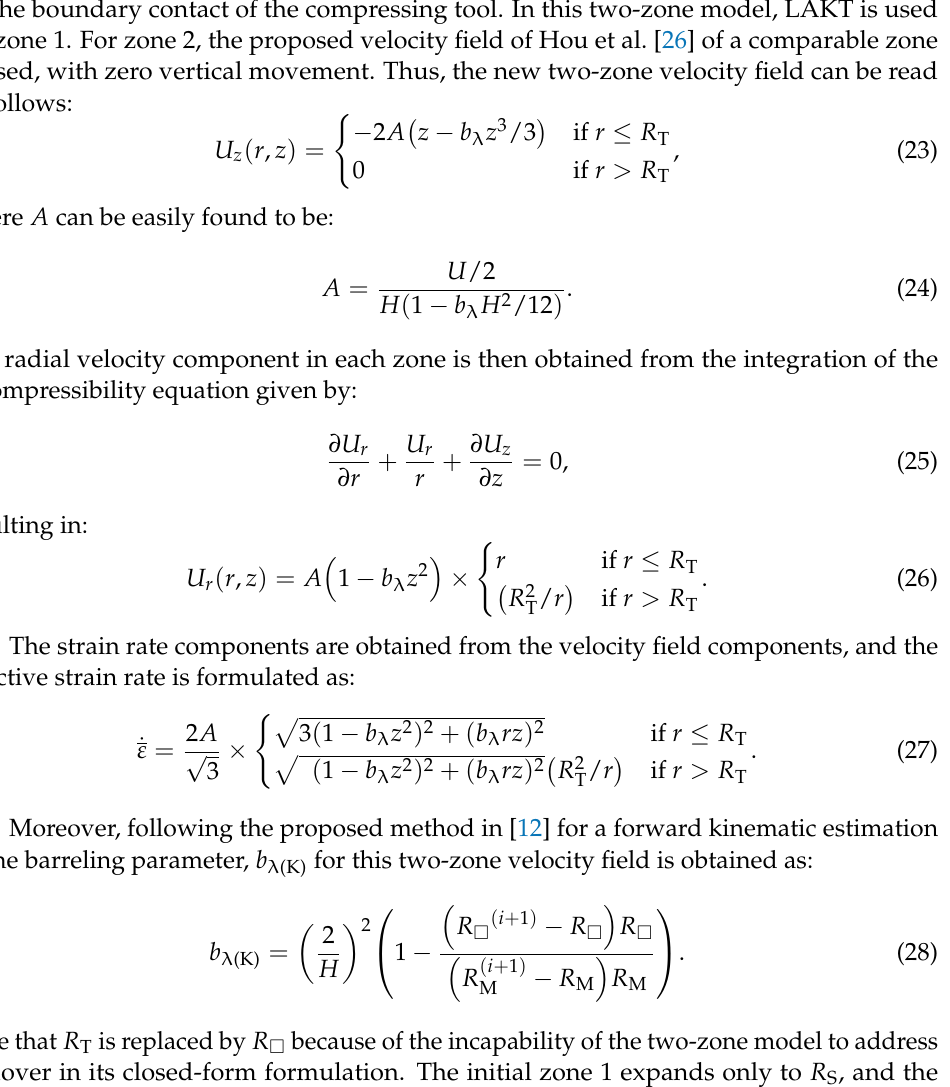
Figure 8. The schematic of the newly proposed model that divides the sample into two zones, with zone 1 for 0 ≤ r ≤ R T and zone 2 for R T < r ≤ R ( z ) . The border of zones 1 and 2 is at r = R T . The downward material flow in zone 2 (unlike in zone 1) is not directly